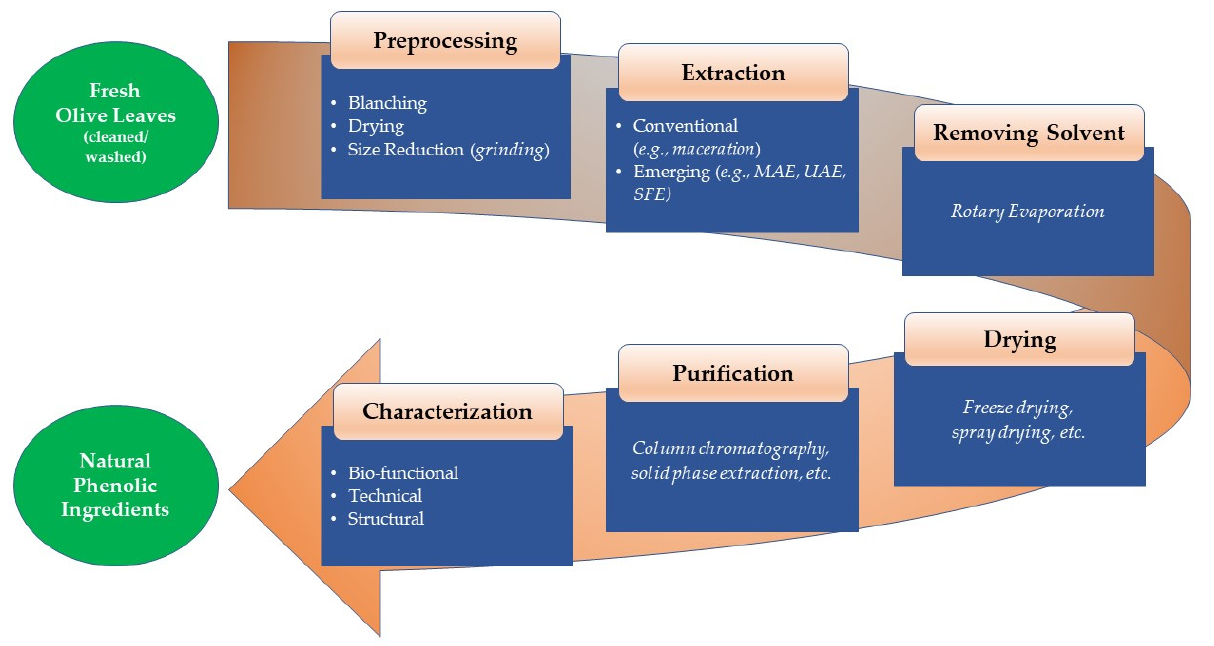
Figure 1. Typical steps associated with phenolic extraction from olive